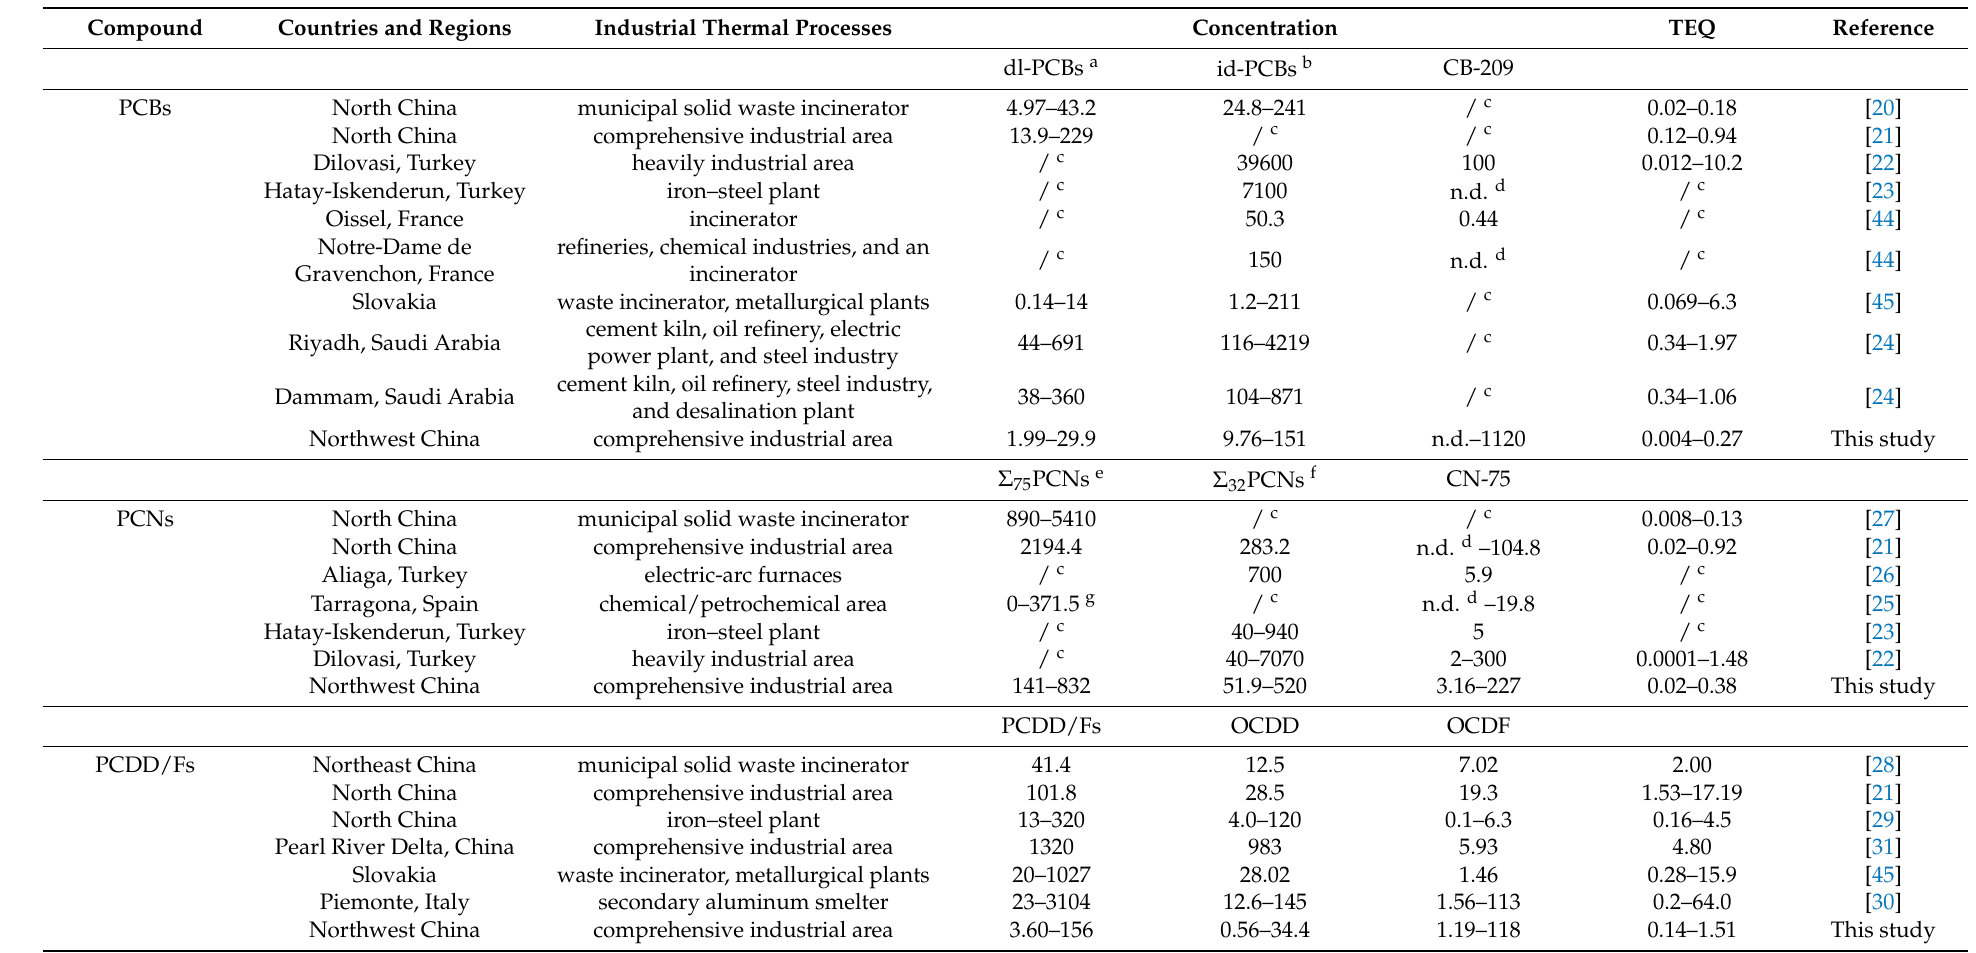
Table 1. The concentrations (range or average) of PCBs, PCNs, and PCDD/Fs in soil samples collected around the industrial park (pg/g).